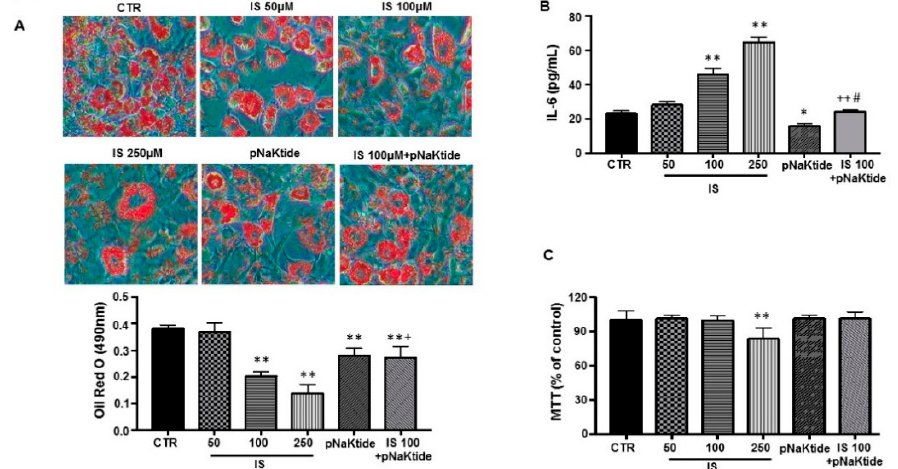
Figure 1. Dose dependent effect of IS exposed to 3T3-L1 murine pre-adipocytes and treated with or without pNaKtide: ( A ) representative images and quantitative data of adipogenesis measured as the relative absorbance of Oil Red O. Images taken with 40 × objective lens; ( B ) quantitative analysis of pro-inflammatory cytokine IL-6; and ( C ) MTT assay represented as percentage of control. Values represent means ± SEM ( n = 6). * p < 0.05 vs. CTR, ** p < 0.01 vs. CTR, + p < 0.05 vs. IS 100 µ M, ++ p < 0.01 vs. IS 100 µ M, # p < 0.05 vs.